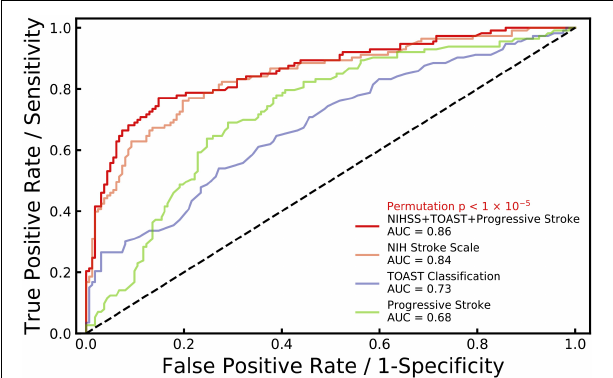
FIGURE 2 | ROC curves generated for stroke with dysphagia. Receiver operating characteristic (ROC) curve is generated for NIH stroke scale (NIHSS), TOAST classification and progressive stroke (age and gender effects included) with dysphagia (red line, AUC = 0.86, permutation p < 1 × 10 − 5 ) based on multiple logistic regression. In addition, ROC curves are generated separately for NIHSS (orange, AUC = 0.84), TOAST classification (blue, AUC = 0.73) and progressive stroke (green, AUC = 0.68) with age and gender effects